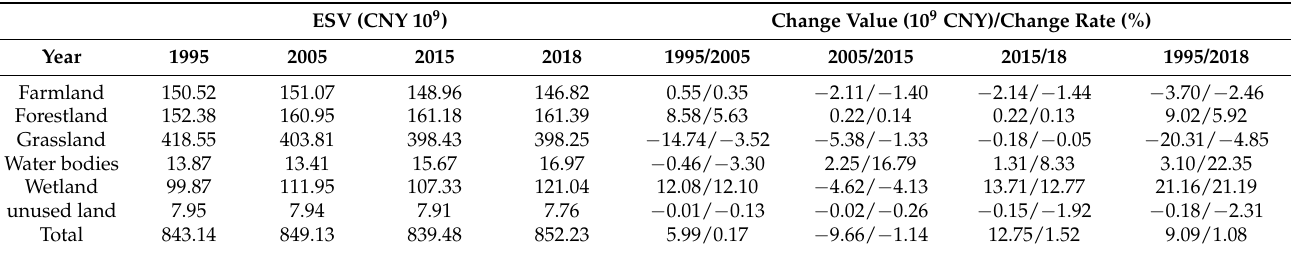
Table 4. Ecosystem service value (ESV) of various landscape types in the Yellow River Basin (China) in 1995 and 2018.